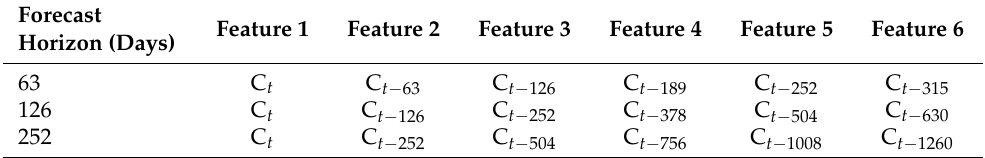
Table 1. Steps used as features. C t means Close Price at time t